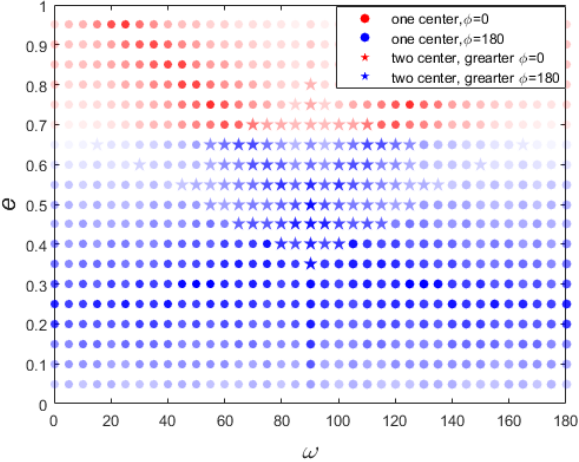
Figure 7. Same as Figure 4, but for polar 2/3 resonance.